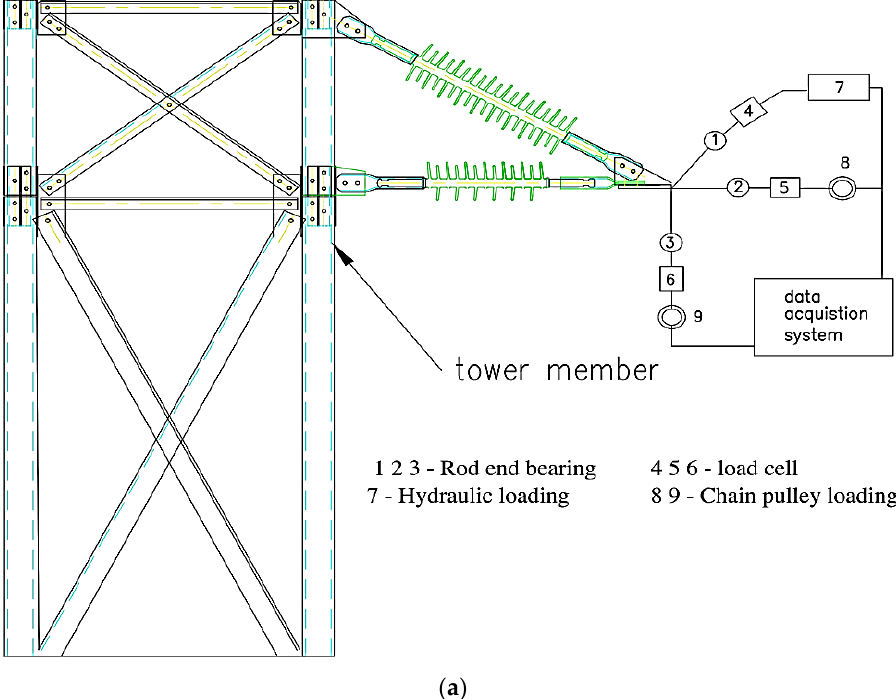
( b ) Figure 12. ( a ) The systematics of the test setup and ( b )photograph of the composite cross-arm under mechanical testing [34].